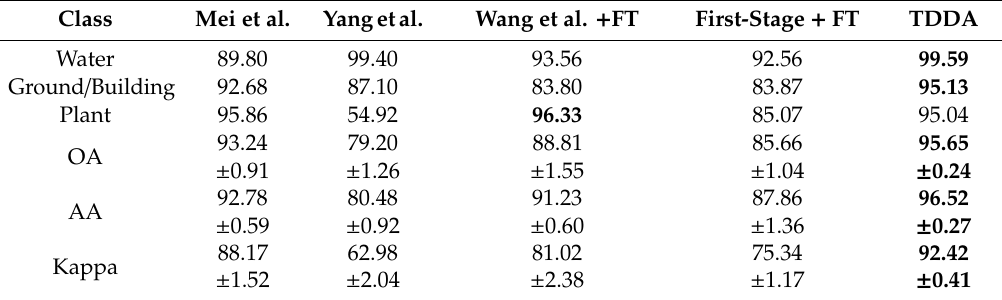
Table 8. Classification accuracy and kappa (%) on Shanghai → Hangzhou dataset. Class